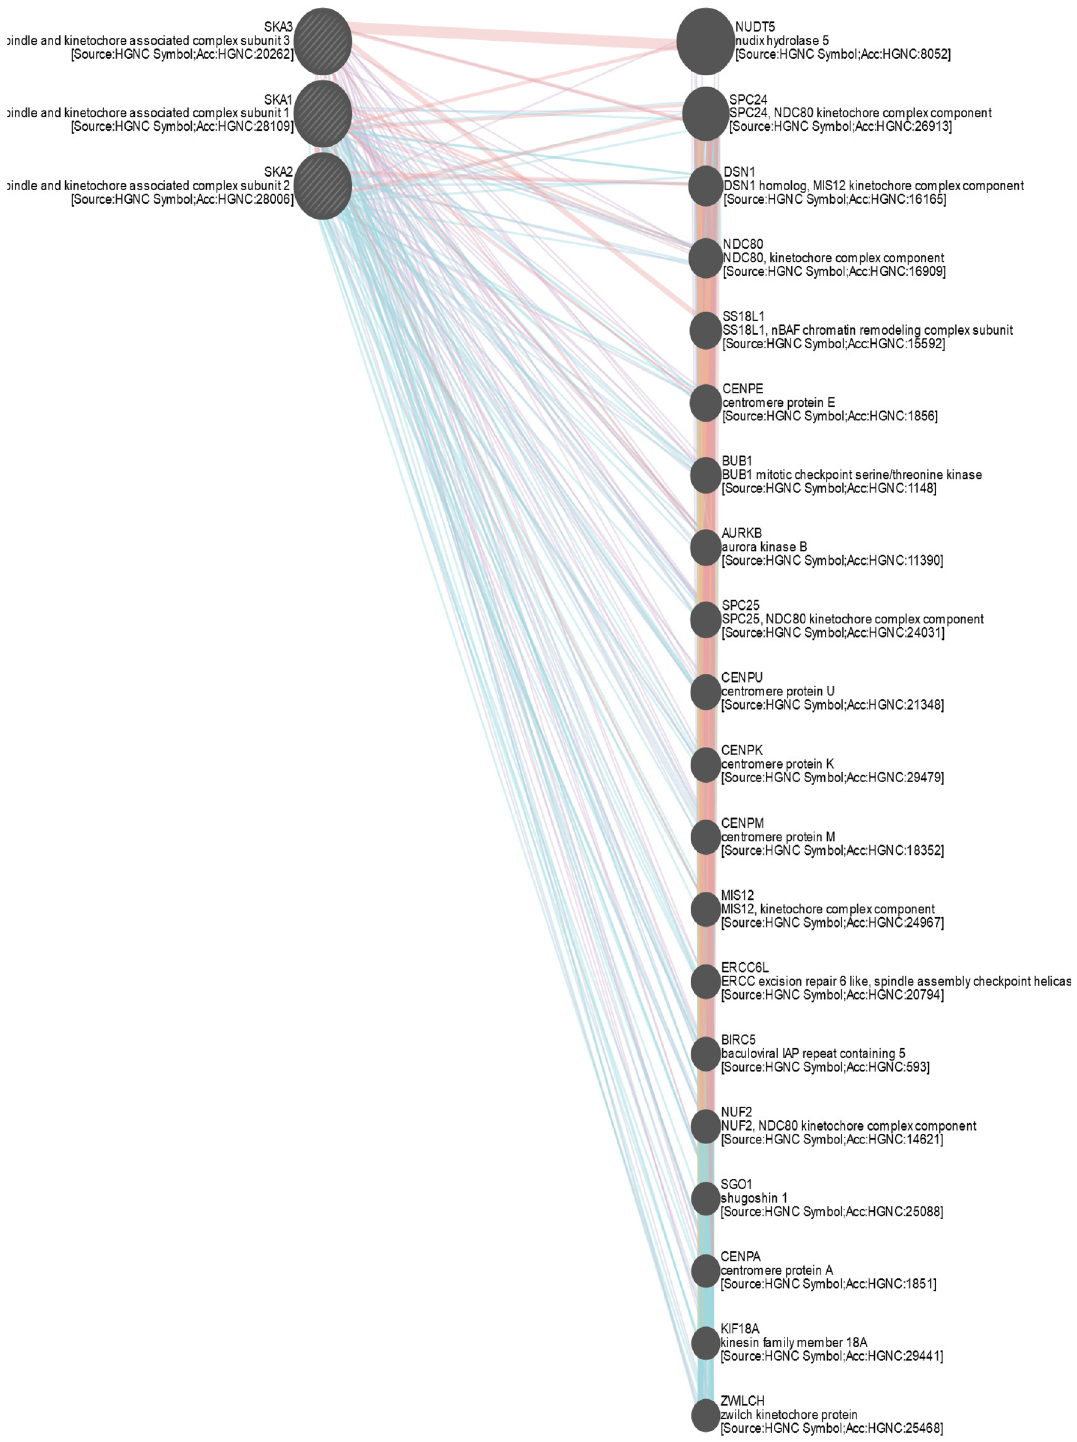
Figure 6. Gene–gene network of SKAs in HCC patients (GeneMANIA). GeneMANIA database identified 20 genes most associated with